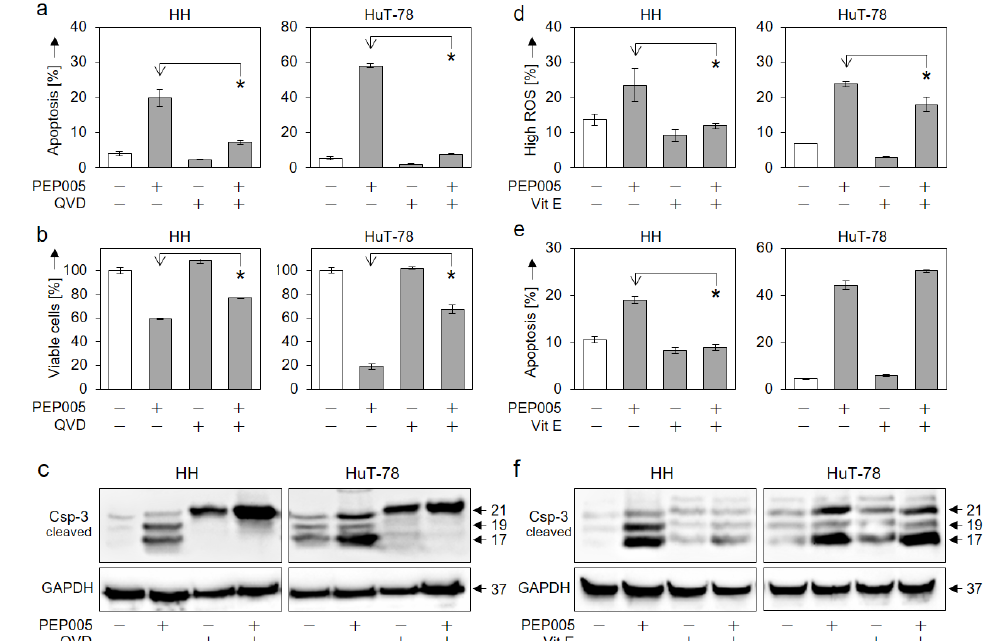
Figure 5. Inhibition of PEP005-mediated effects by QVD-Oph and vitamin E. Antagonistic effects of the pan-caspase inhibitor QVD-Oph (QVD, 5 µ M, a – c ) and of the antioxidant vitamin E (VitE, 1 mM, d – f ) were determined in HH and HuT-78 cells. Assays included the determination of apoptosis ( a , e , 48 h), cell viability ( b , 48 h), ROS production ( d , 24 h) and caspase-3 processing ( c , f , Western blots, 24 h). ( a , b , d , e ) Mean values of triplicates ± SDs of representative experiments are shown. At least two independent experiments were performed. Statistical significance was calculated by using all values (at least 6) and is indicated for combination treatments vs. PEP005 alone (* p < 0.05). ( c , f ) Caspase-3 cleavage products (21, 19, 17 kDa) are indicated. Each 30 µ g of protein extracts were loaded per lane. GAPDH (37 kDa) served as loading control. Two independent series of protein extracts and Western blots revealed highly comparable